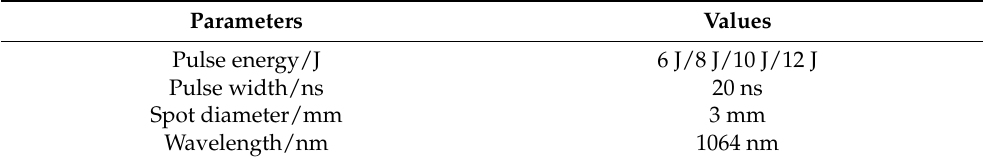
Table 3. Laser shock process parameters.